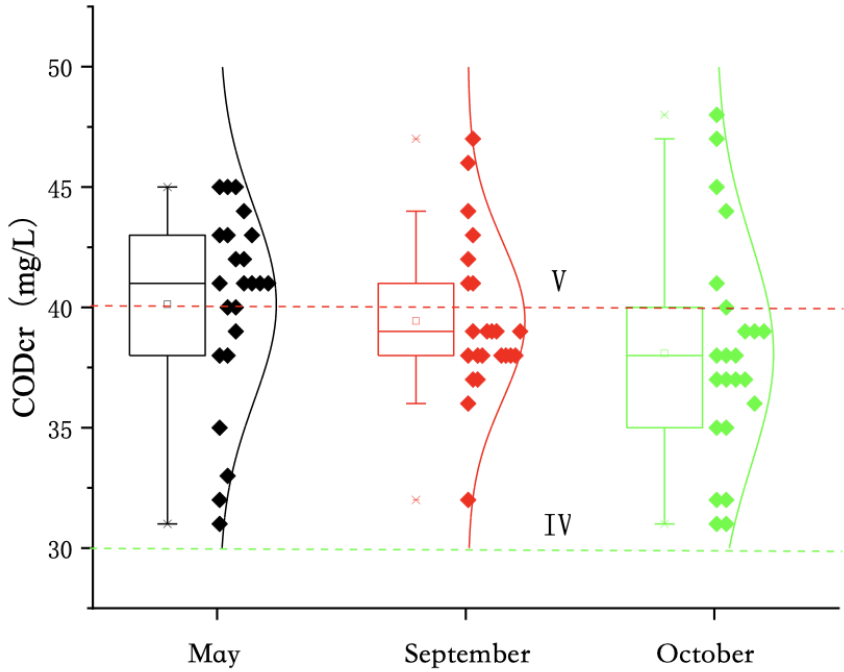
Figure 5. Characteristics of the COD Cr values in the water body of Qinghai Lake in different seasons.